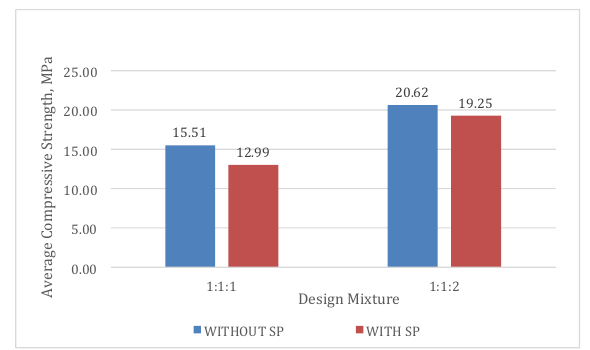
Figure 1. Compressive Strength of GPC without SP and GPC with